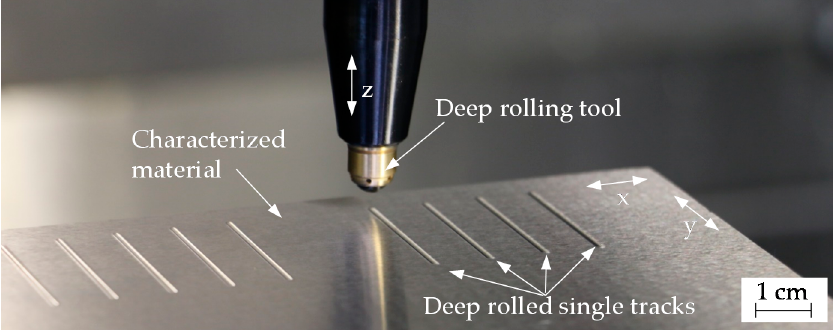
Figure 1. Exemplary presentation of deep rolled single tracks on 100Cr6 SA using a tool with a diameter of 6 mm (varied deep rolling pressure and number of rollovers).